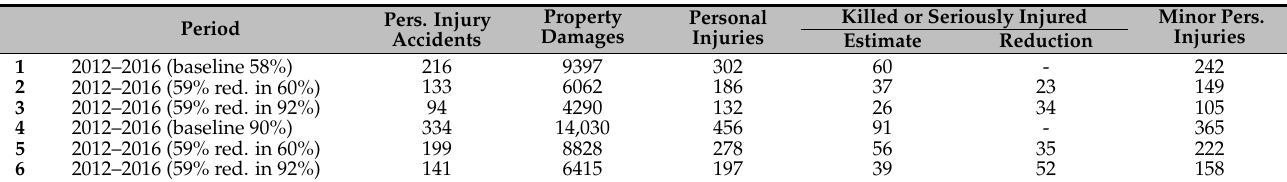
Table 9. Average numbers for accidents involving personal injury and material damage per year during the period 2012–2016. Example calculation of 59% reduction in accident risk as a result of “group discussions aimed at uncovering workplace risk and implementing measures”. Rows 1–3 include trucking companies (58% of HGV kms), while Rows 4–6 also include companies involved in transport for own account (90% of HGV